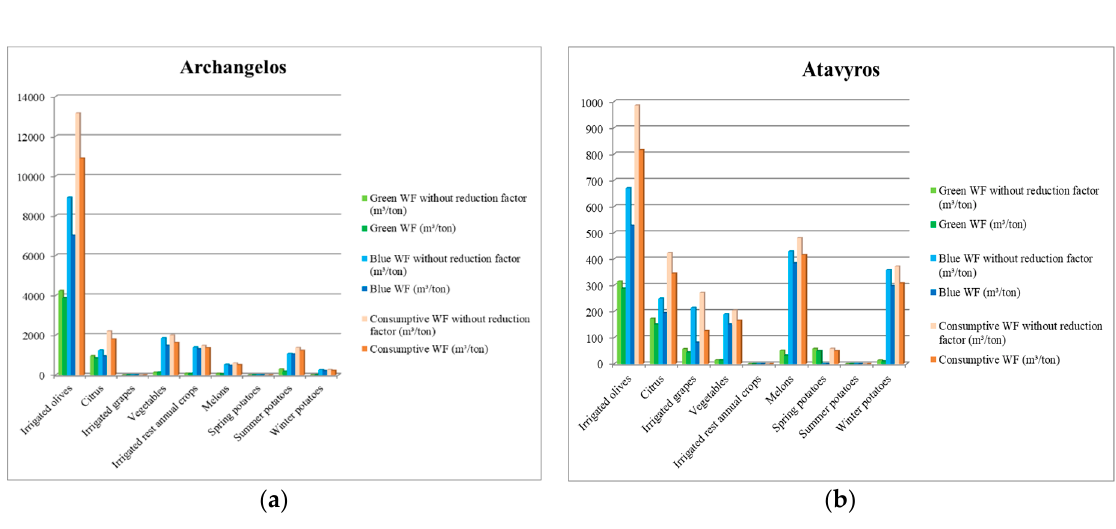
Figure 3. Comparison of blue, green, and consumptive WF of irrigated crops, with and without inclusion of the reduction factor for the MU of ( a ) Archangelos and ( b ) Atavyros.